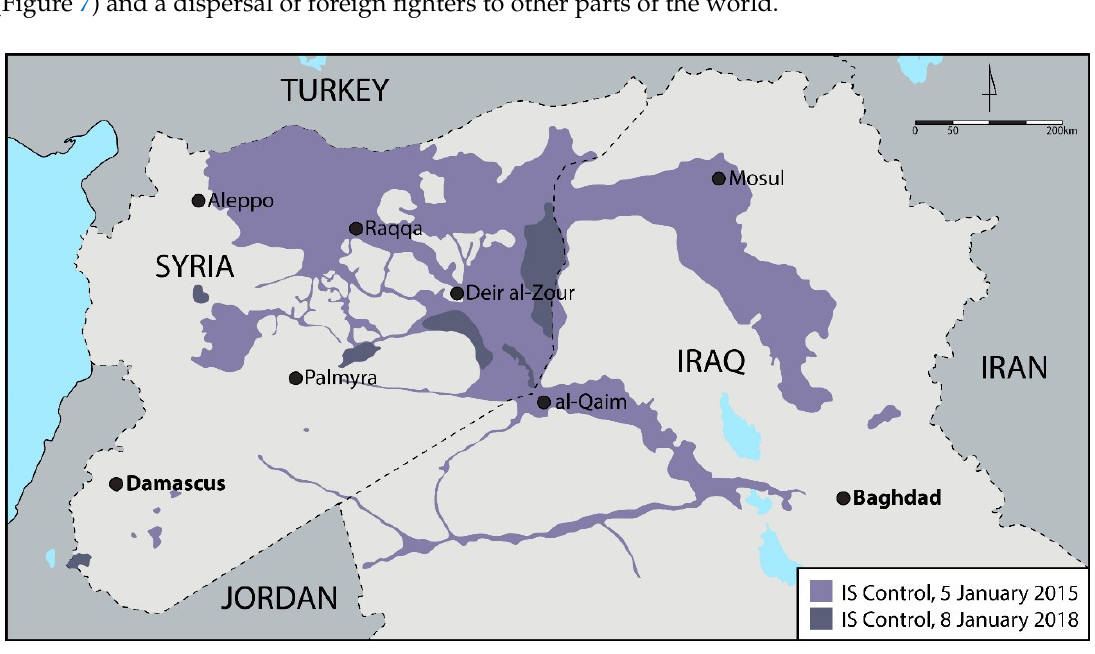
Figure 7. Contraction in the lands controlled by Da’esh/the Islamic State between 5 January 2015 and 8 January 2018. Source IH Conflict Monitor.